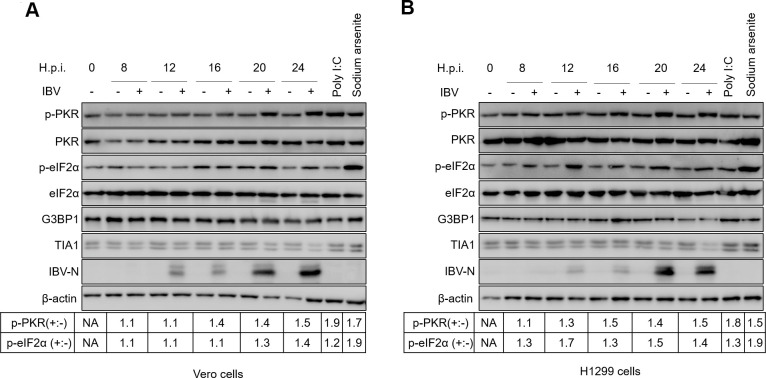
PKR and eIF2α phosphorylation status during IBV infection.(A and B) Vero and H1299 cells were infected with IBV at a MOI of 1. Mock infection was included as negative control, poly I:C transfection for 6 h or 1 mM sodium arsenite for 30 min were included as positive control. Cells were harvested at the indicated time points and processed for western blot analysis using 10 μg total protein per lane. p-PKR, PKR, p-eIF2α, eIF2α, G3BP1, TIA-1, and IBV-N were detected with corresponding antibodies. β-actin was probed as a loading control. The representative images of two independent experiments were shown. The signals of protein bands were determined by Image J. The intensities of p-PKR or p-eIF2α were normalized to total PKR or total eIF2α. The ratio of p-PKR and p-eIF2α in IBV-infected cells, poly I:C-transfected cells, or sodium arsenite-treated cells, to mock-infected cells, were shown as p-PKR (+:-) or p-eIF2α (+:-).